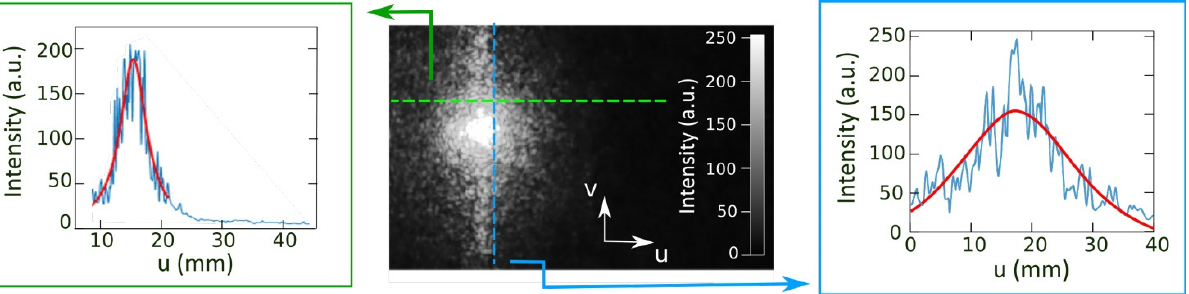
Figure 10. Picture of the laser spot on the target and graph of its vertical and horizontal sections. In each graph, the blue line plots experimental data, while the red line is the fit with the Lorentzian-like function.